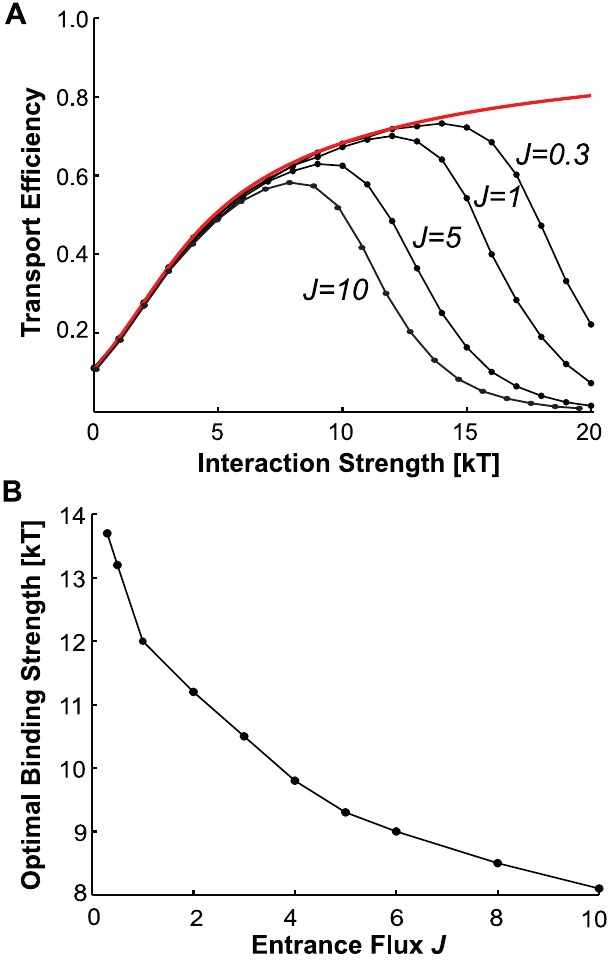
Figure 3. Transport Efficiency Is Determined by the Interaction Strength (A) Transport efficiency, as given by the probability to reach the nucleus, is shown as a function of the interaction strength. RanGTP activity in the nucleus is represented by using J ran L 2 /(N 2 D) ¼ 1.5. The curves correspond to four different values of the entrance rate, J (measured in units of 10 (cid:2) 4 16D/R 2 ); the red line is the low-rate limit of Equation 4. For any entrance rate, the transport efficiency is maximal at a specific value of the interaction strength, which provides a mechanism of selectivity. (B) Optimal interaction strength of (A) as a function of the incoming rate J (in units of 10 (cid:2) 4 16D/R 2 ), for J ran L 2 /(N 2 D) ¼ 1.5; parabolic potential shape. See Discussion for the corresponding actual values of the flux through the pore. Black dots are simulation results.